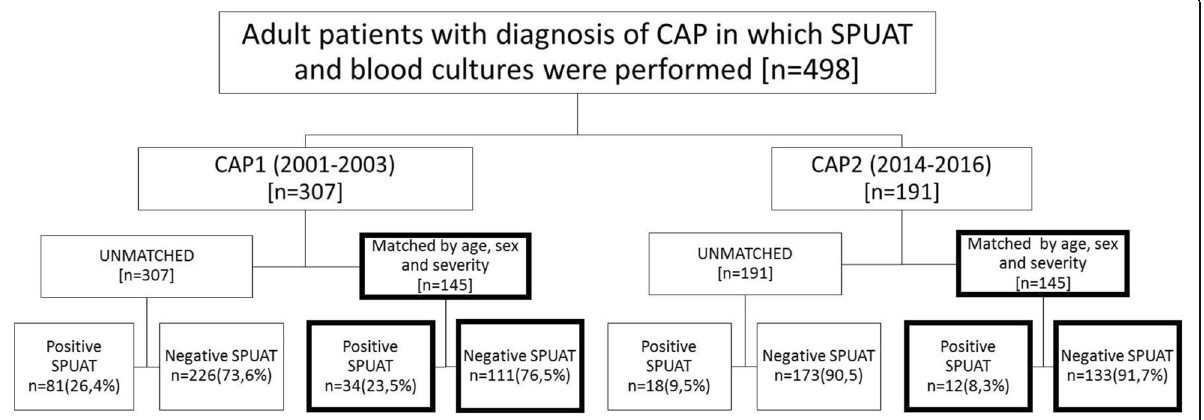
Fig. 1 Distribution of the patients in the cohorts CAP1 and CAP2 in general and considering the approaches analyzing both cohorts, unmatched and matched. The unmatched patients, both from CAP1 and CAP2 cohorts, were excluded because they had no pair with comparable age, sex and PSI score. The number of patients excluded from the case-control analysis were 162 from the CAP1 and 46 from the CAP2